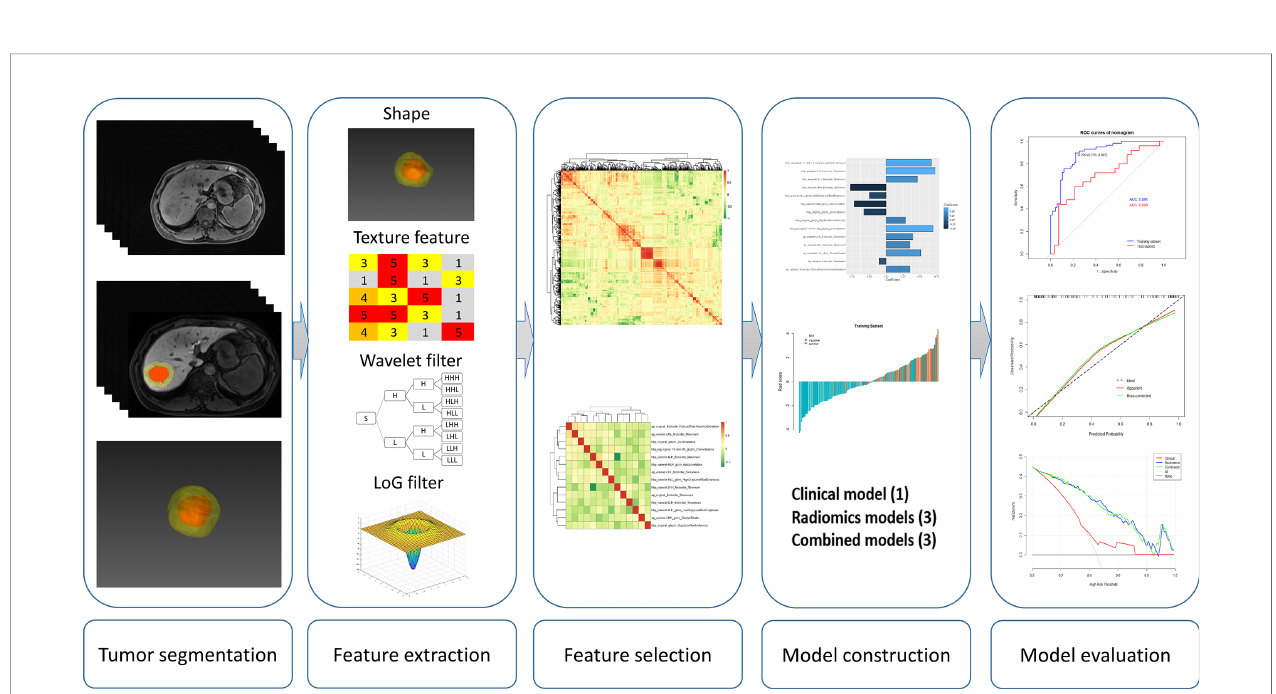
FIGURE 2 | Work fl ow of key steps in this